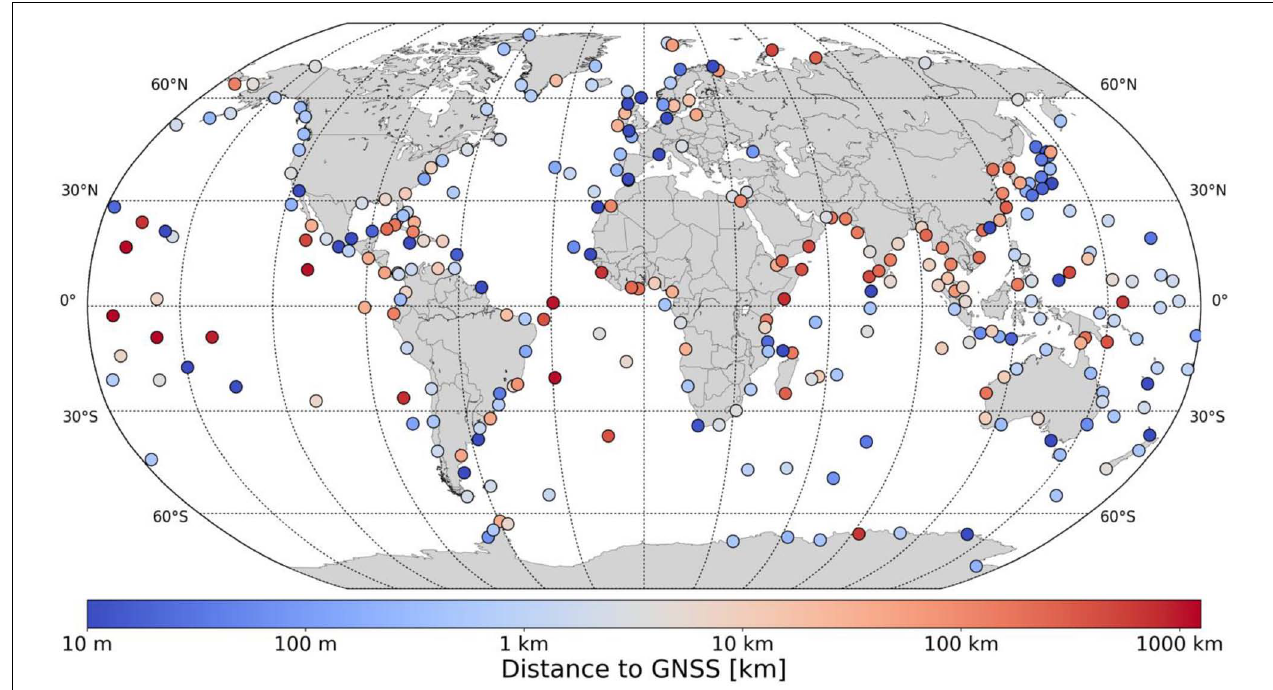
FIGURE 8 | Distance between tide gauge and GNSS